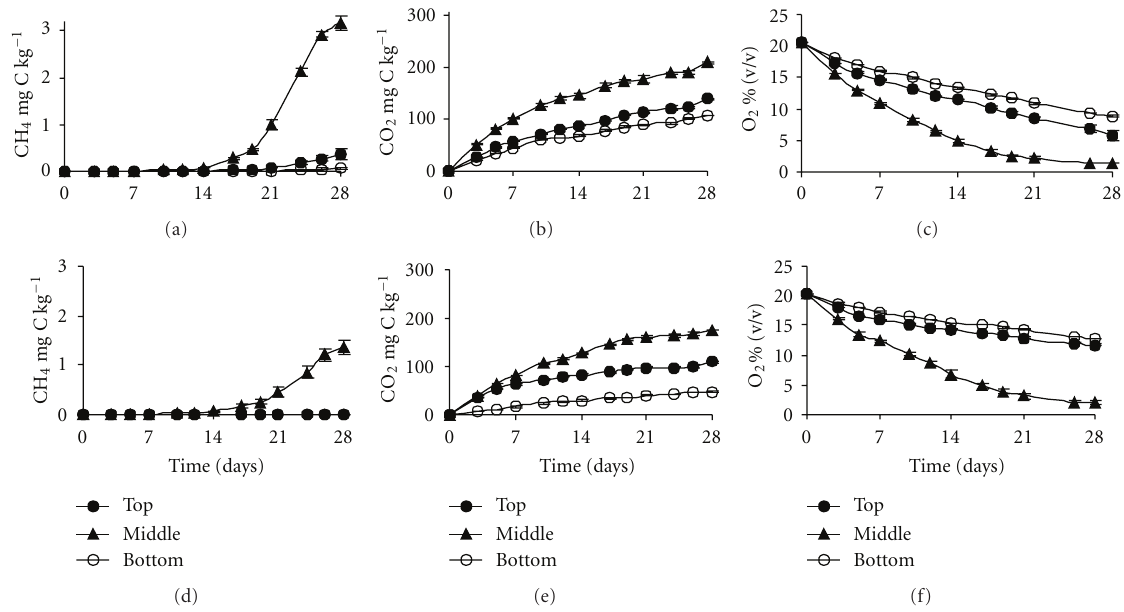
Figure 1: Changes of CH 4 , CO 2 and O 2 over time in loess soils collected from three slope positions and incubated under flooding (methanogenic potential). Top: summit, Middle: back slope, Bottom: bottom of the slope. Upper graphs (a–c) upper soil depth of 0–20 cm; lower graphs (d–f) lower soil depth of 20–40 cm. (a) and (d) cumulative CH 4 production; (b) and (e) cumulative CO 2 production; (c) and (f) changes in O 2 in the headspace. Points represent triplicate-means with standard